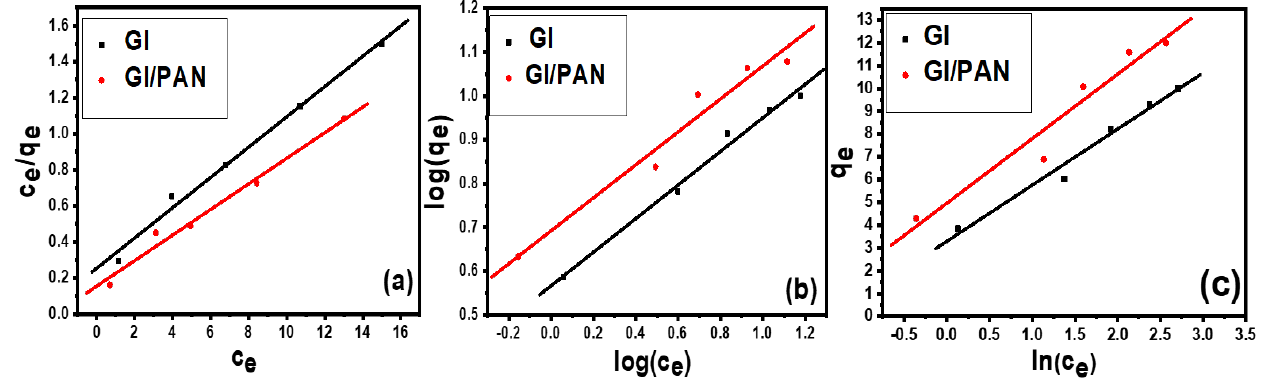
Figure 6. Plots of adsorption isotherms for the adsorption of CR dye by 50 mg of Gl, and Gl/PAN composite at 25 °C and initial pH 7: ( a ) Langmuir isotherms model; ( b ) Freundlich isotherms model; and ( c ) Tempkin isotherms model. Table 2. Isotherm parameters for CR adsorption on Gl and Gl/PAN. Langmuir